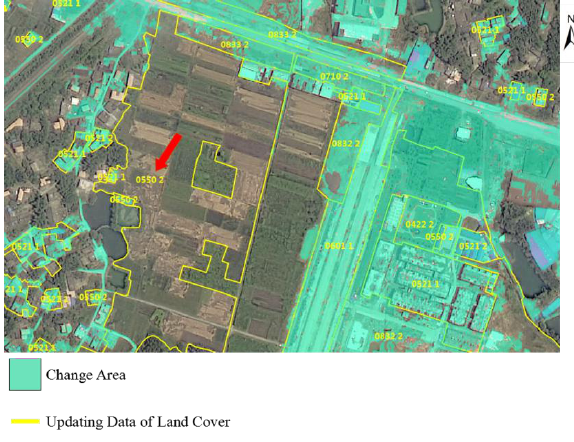
Figure 8. The inspection of incorrect update